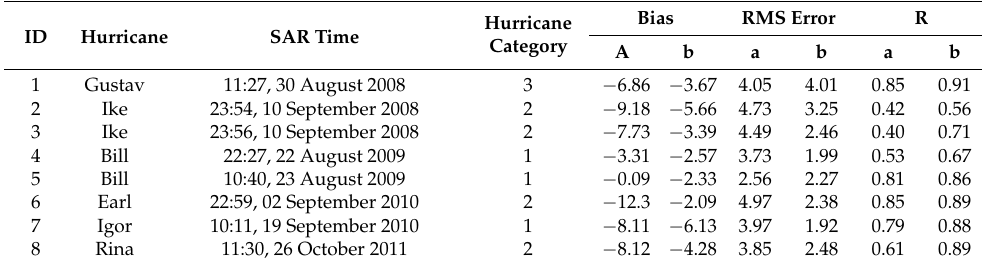
Table 1. Statistics for VH SAR and HWIND wind speed before and after wind correction due to heavy rain contamination: ‘a’ columns show results without rain correction, ‘b’ columns show results with rain correction. The hurricane category is indicated following the Saffir-Simpson scale at the time of the SAR